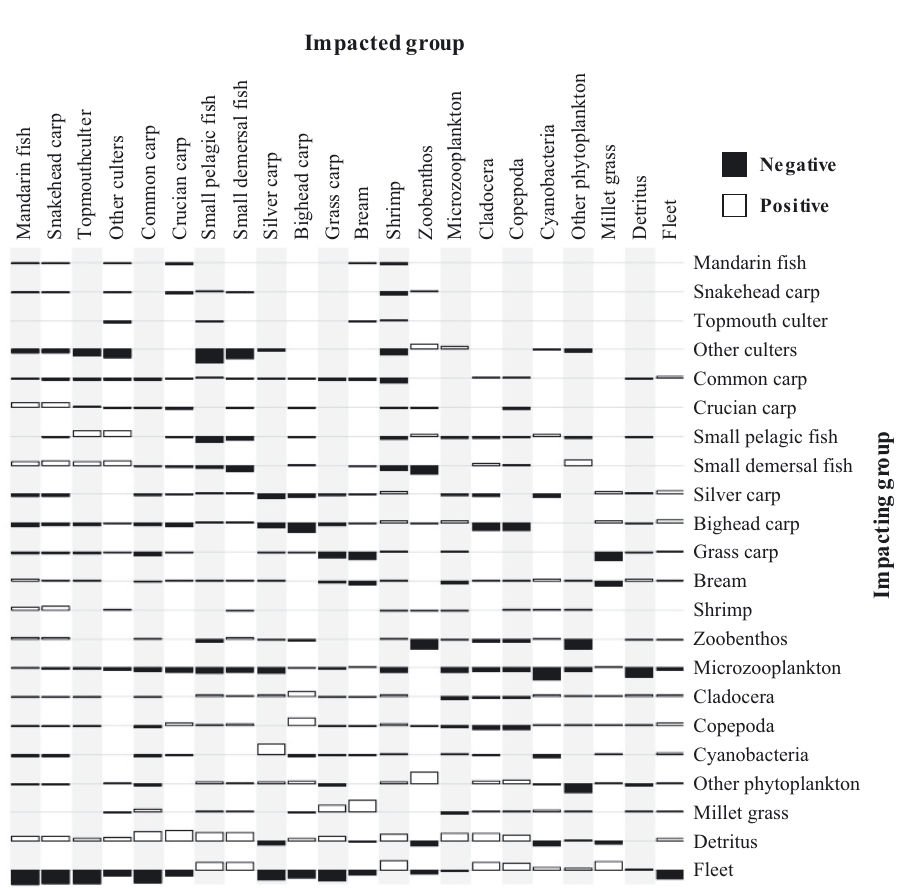
Fig. 3. Mixed trophic impacts of the Lake Shangshe ecosystem. The black bars pointing downwards show the negative impact on the functional groups, while the white bars pointing upwards indicate the positive impacts. The heights of the bars are proportionate to the degree of the impact, and values range from −1 to +1